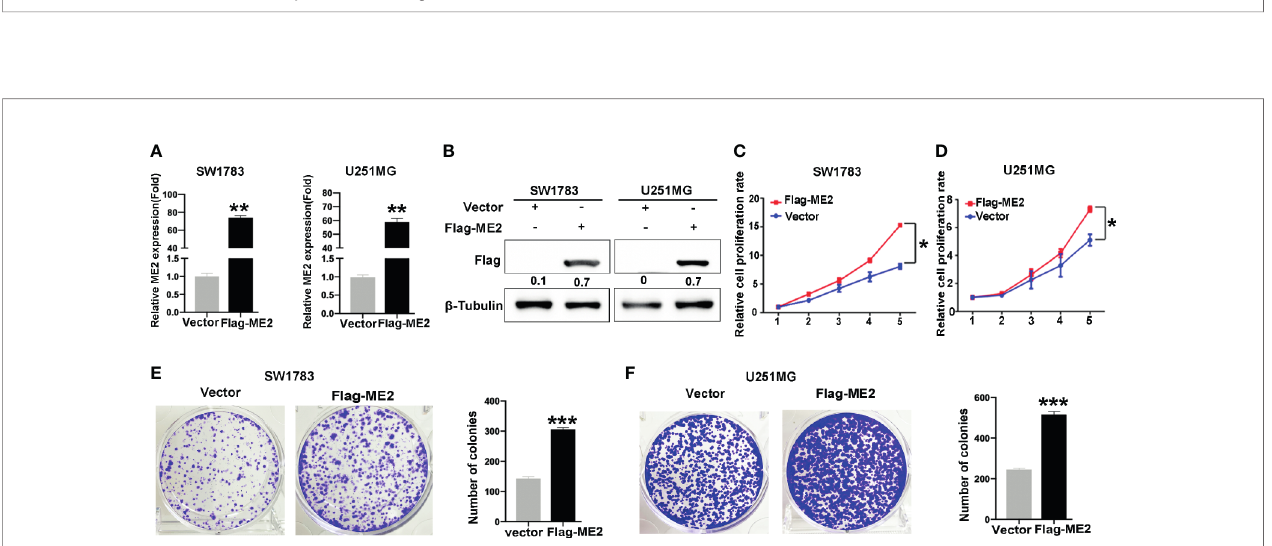
FIGURE 3 | Overexpression of ME2 promotes proliferation of GBM cells. (A) ME2 overexpression detected by real-time PCR in SW1783 and U251MG cells (**P < 0.01). (B) Western blotting to con fi rm ME2 expression in in SW1783 and U251MG cells transfected with vector or Flag-ME2 plasmids. (C, D) Effects of ME2 overexpression on proliferation of SW1783 and U251MG cells determined by CCK-8 assay (*P < 0.05). (E, F) Colony formation assay to determine the colony formation of glioma cells (***P <